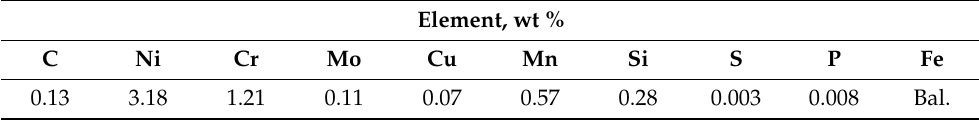
Table 1. Chemical composition of the studied AISI 9310 steel.